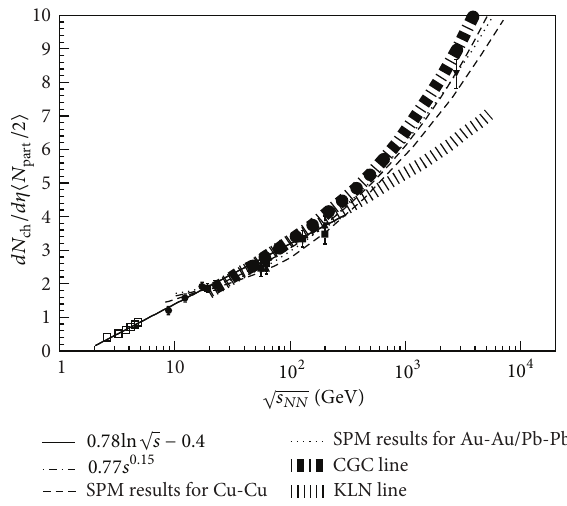
Figure 10: Energy dependence of charged hadron mid-pseudo- rapidity density per participant pair. SPM [90], CGC, and KLN models [113] results are shown.